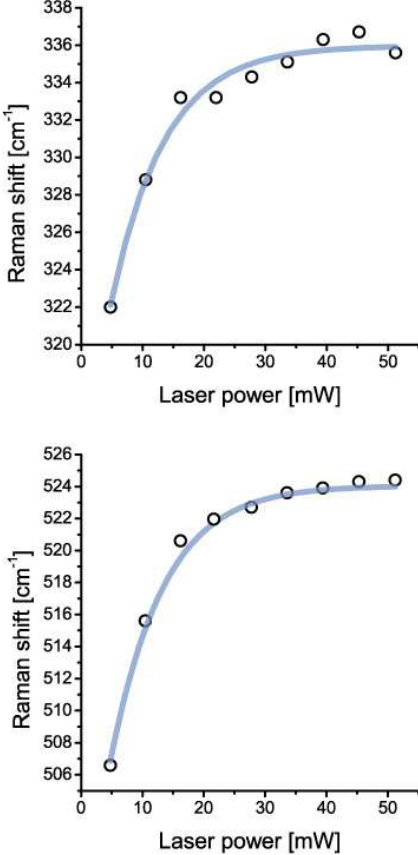
Figure 7. Boltzmann sigmoidal fit of the blue shift of prominent coesite bands at 330 and 520 cm −1 independent of laser excitation (532 nm). The significant blue shift (~18 cm −1 ) results from the strain generated by the lattice mismatch between primary stishovite (now only remnants) and the resulting coesite. The amount of the blue shift is quasi-reversible due to the blue shift decline over time signaling the destruction of the metastable coesite lattice. Note that no synthetic coesite, stishovite, or mix of those mineral phases, shows such a blue